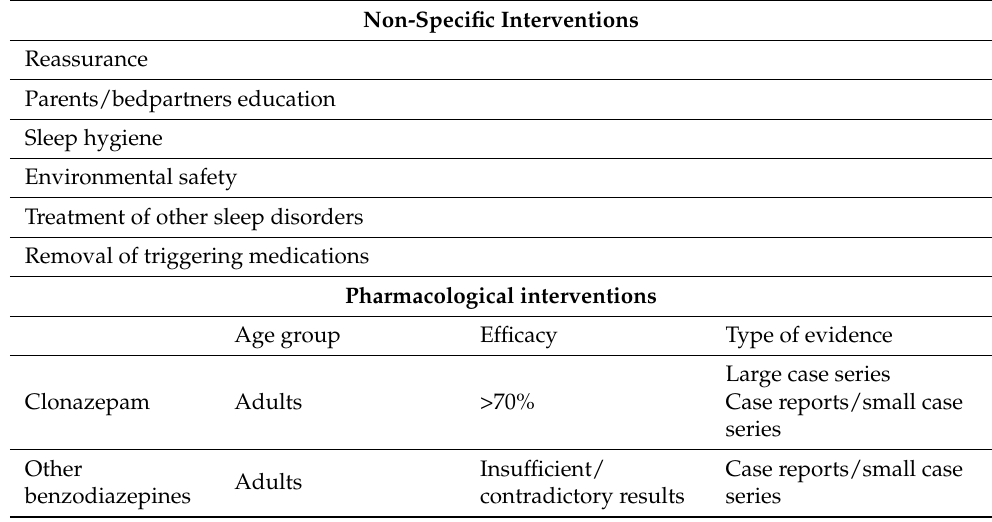
Table 7. Treatment approaches available for